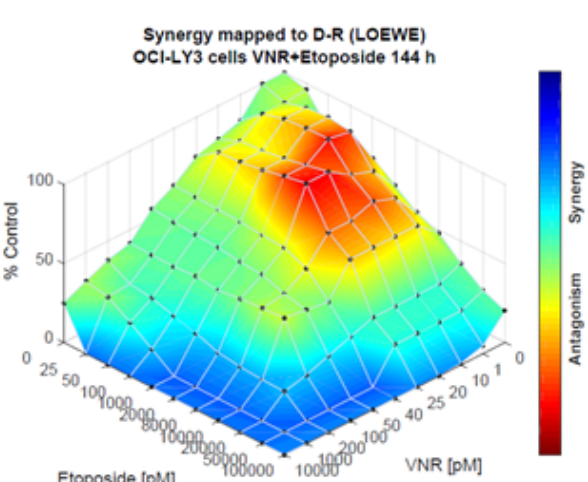
Figure 1. ( A ) Antiproliferative effects of metronomic vinorelbine and metronomic etoposide after 144 h of exposure. Columns and bars, mean values ± SEM, respectively. * p < 0.05 vs. vehicle ‐ treated controls. ( B ) Combination index (CI) ‐ fraction affected (Fa) plot of the metronomic vinorelbine (VNR) and etoposide (ETO) combination 144 h at the molar ratio of 1:100 in OCI ‐ LY3 cell line; CI < 1, CI = 1 and CI > 1 indicate synergism, additive effect, and antagonism, respectively. ( C ) The 3 ‐ dimensional landscape of the dose matrix of combination responses for metronomic VNR and met ‐ ronomic ETO based on the Loewe model, where blue reflects evidence of synergy and red represents evidence of antagonism. The model supported synergy of the combination in reducing OCI ‐ LY3 cell line viability. Cell viability was plotted as % control.